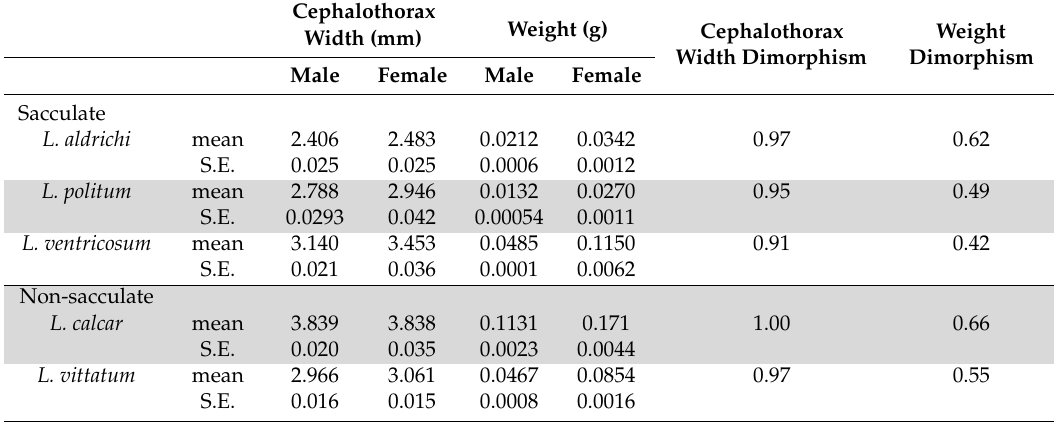
Table 2. Variation in size (both cephalothorax width and weight) of male and female Leiobunum harvestmen of the five species studied. The mean ± S.E. are listed, as well as the sexual dimorphism for each size measurement per species, calculated from the male/female ratio. Species are arranged from low antagonism at the top of the table to high antagonism at the bottom of the table, and categorized by the possession of penile sacs (sacculate) or the absence of penile sacs (non-sacculate). Cephalothorax Width (mm) Weight (g) Cephalothorax Width Dimorphism